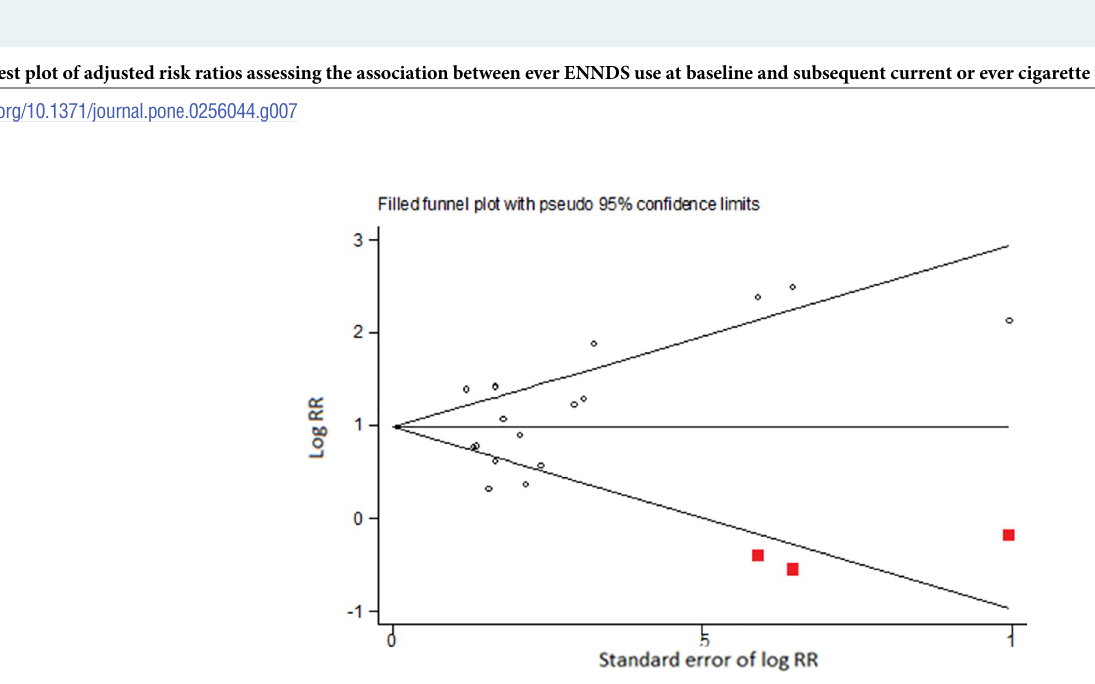
PLOS ONE | https://doi.org/10.1371/journal.pone.0256044 September 8,